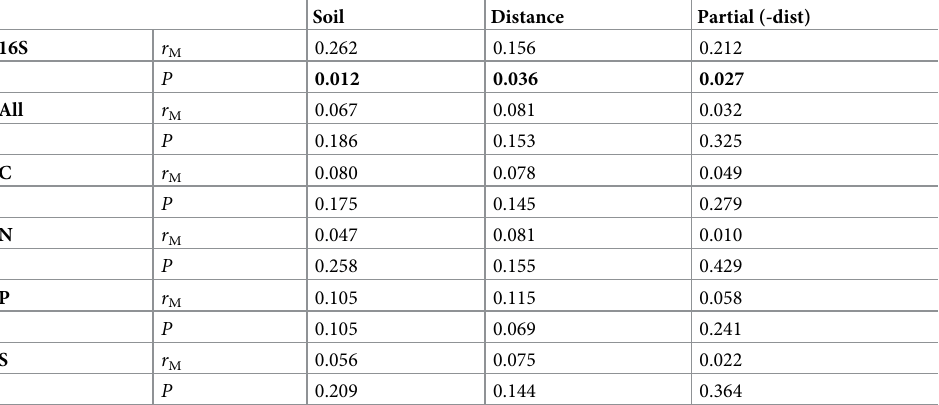
Table 3. Mantel and partial Mantel test results with microbial communities, soil characteristics and geographic distances.